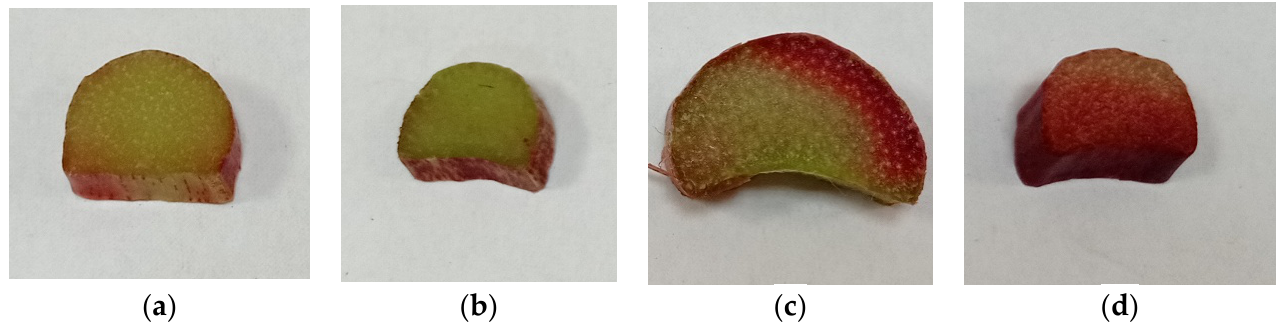
Figure 2. Appearance of rhubarb stalk slices of the four cultivars examined: ( a ) Malakhit, ( b ) Krupnochereshkovy, ( с ) Upryamets, ( d ) Zaryanka. Table 2. Varietal differences in biochemical characteristics of rhubarb